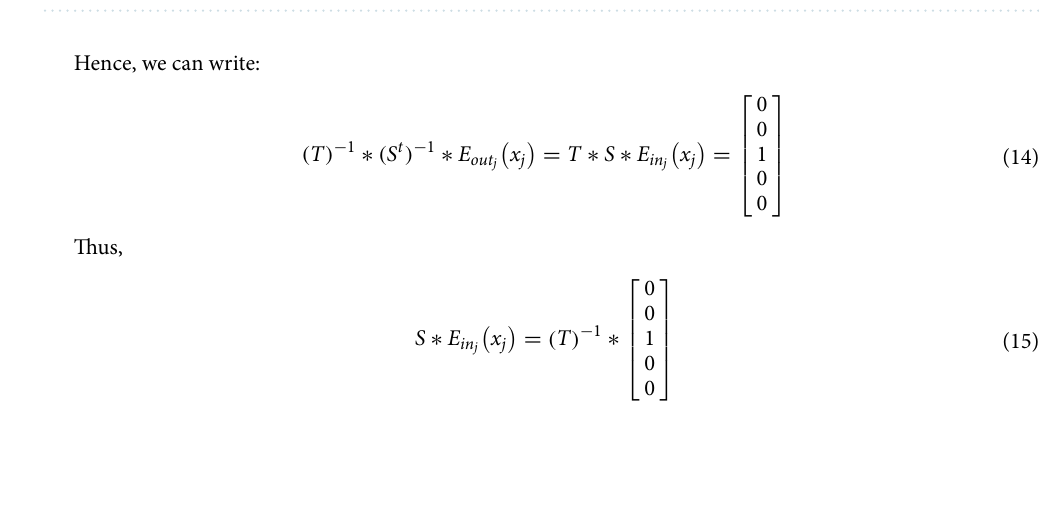
Figure 11. ( a ) Illustration of the Axial Tuning of focus on two different planes using the corresponding optimized phase map, ( b ) Illustration of Lateral shifting of focus by applying a linear phase gradient to the optimized